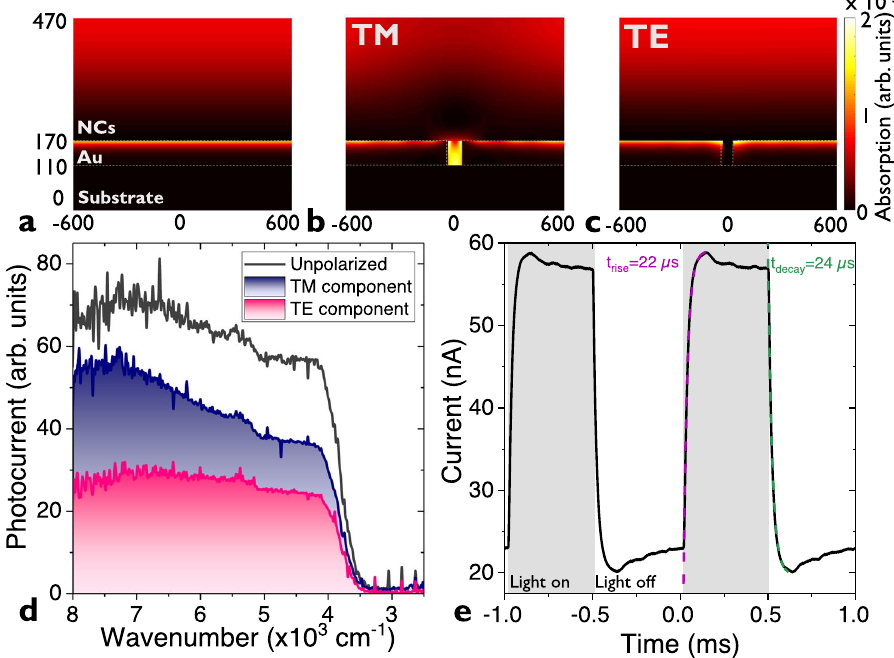
Fig. 5 Optical properties of the array of HgTe nanocrystals (NCs) deposited on a nanotrench electrode. a Absorption map at 2.5 µ m of a 300-nm fi lm of NCs on a gold mirror. b . (resp. c ) Absorption map at 2.5 µ m of a 300-nm fi lm of NCs on a 40-nm nanotrench in TM (resp TE) polarization. TM (resp. TE) polarization correspond to the magnetic (resp. electric) fi eld along the trench. The axes are in nm. d Photocurrent spectrum for a HgTe NC array deposited on a 40-nm nanotrench electrode with and without a polarizer. The bias is 1 V and measurement is conducted at room temperature. e Current as a function of time for a HgTe NC array deposited on a 40-nm nanotrench electrode as the illumination is turned on and off. Pink and green dashed lines correspond to an exponential fi t of the rise and the decay as the light is turned on and off. Measured rise and decay time are 22 and 24 µ s, respectively. The illumination is ensured by a 1.55 µ m laser diode delivering 2 mW of optical power and modulated at 1 kHz. The bias is 1